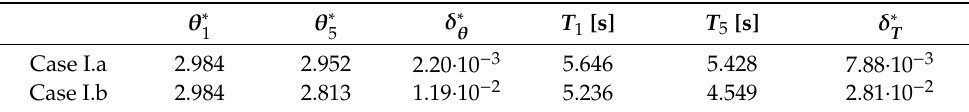
Table 6. Max amplitudes θ ∗ cases I.a and